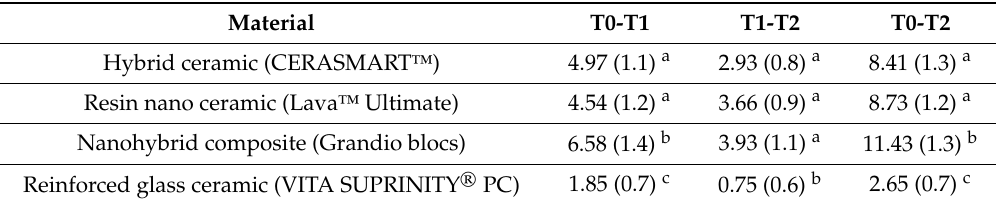
Figure 1. Mean percentage micro-hardness loss for different immersion protocols. Table 3. Mean percentage micro-hardness loss for the investigated materials between different immersion protocols.